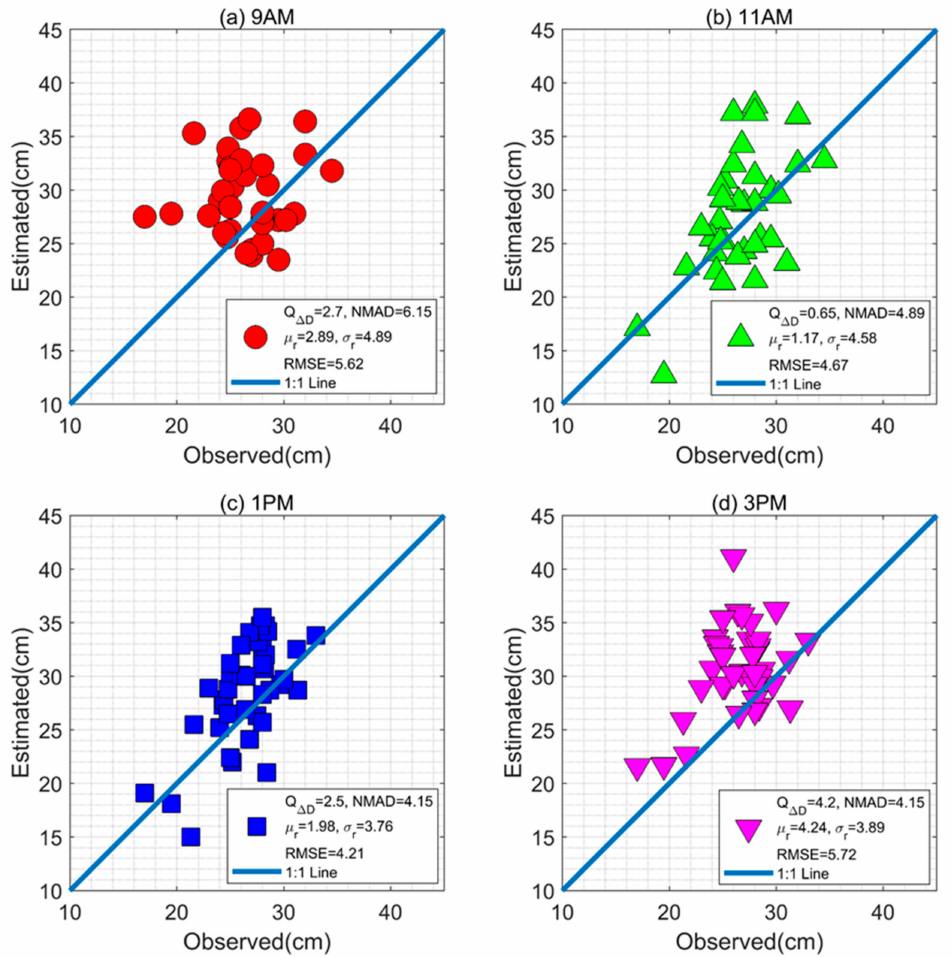
Figure 12. Observed (x) versus estimated snow depth from the UAV photogrammetry (y) classified by surveying time of ( a ) 9 a.m., ( b ) 11 a.m., ( c ) 1 p.m., and ( d ) 3 p.m.. Significant positive bias is apparent for the surveying time of 9 a.m. and 3 p.m.